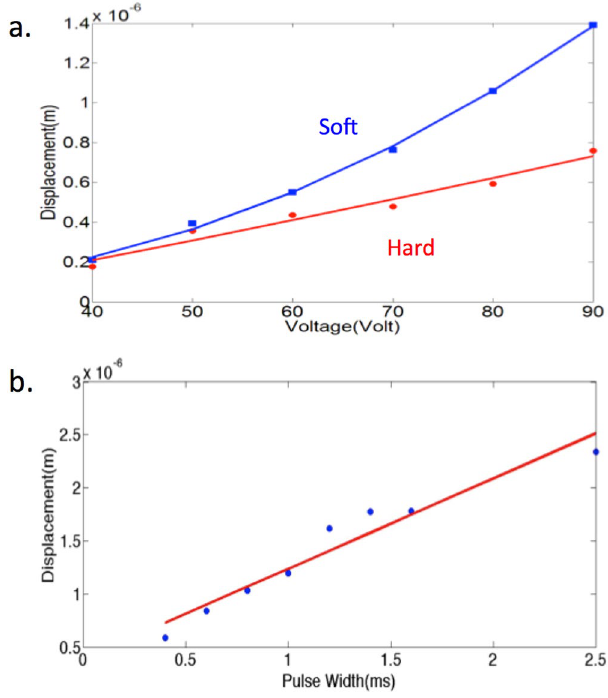
Figure 3. Phantom data. ( a ) Voltage versus displacement for relatively soft and stiff uniform gelatin phantoms. ( b ) Pulse width versus displacement for soft gelatin